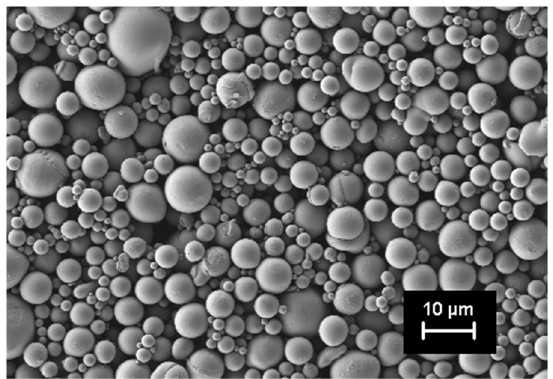
Figure 1. SEM of gas-atomized NiTi 44 powder with particle size <15 µm in initial state for filament production.